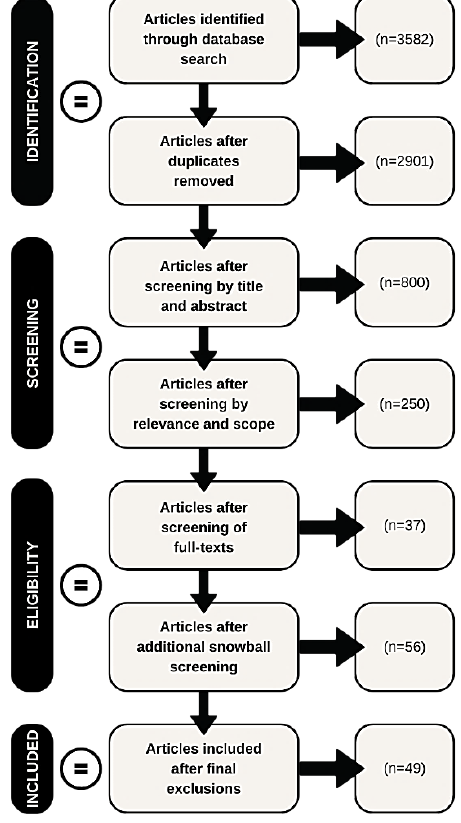
Figure 1. Selection of studies.